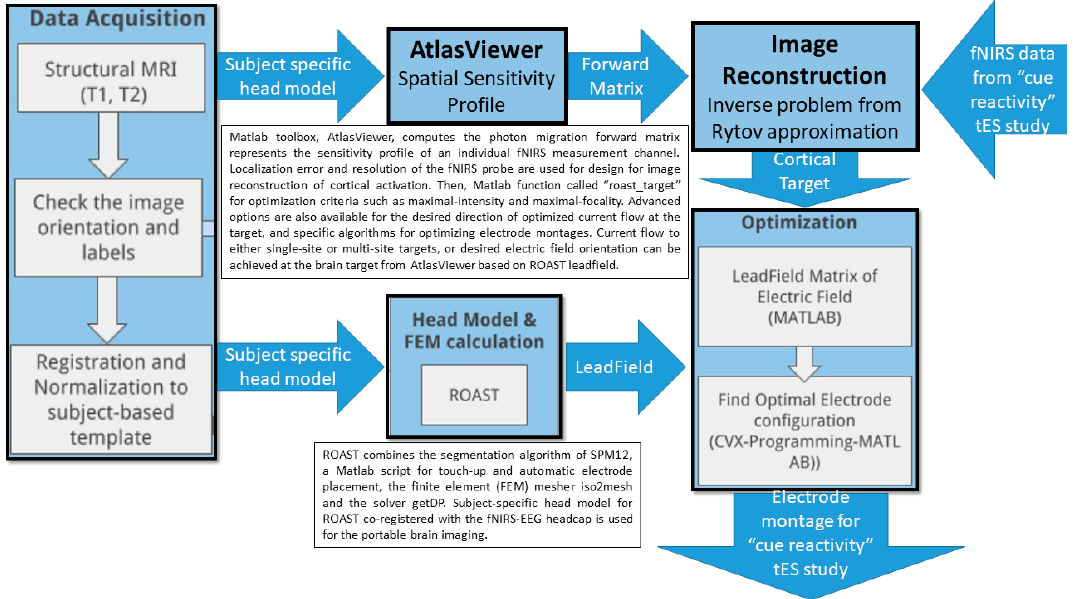
Figure 7. Computational pipeline for portable neuroimaging-guided transcranial electrical